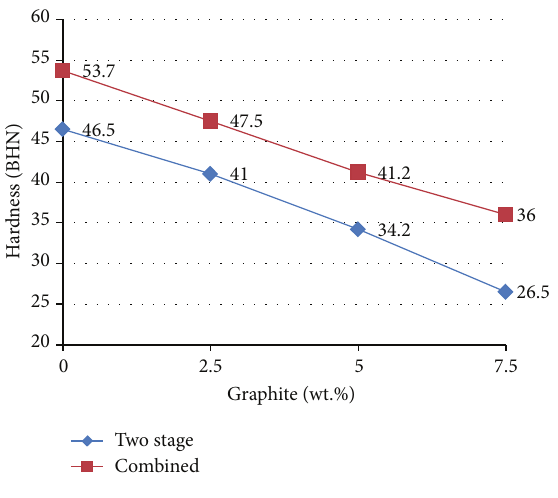
Figure 5: Hardness of specimens.